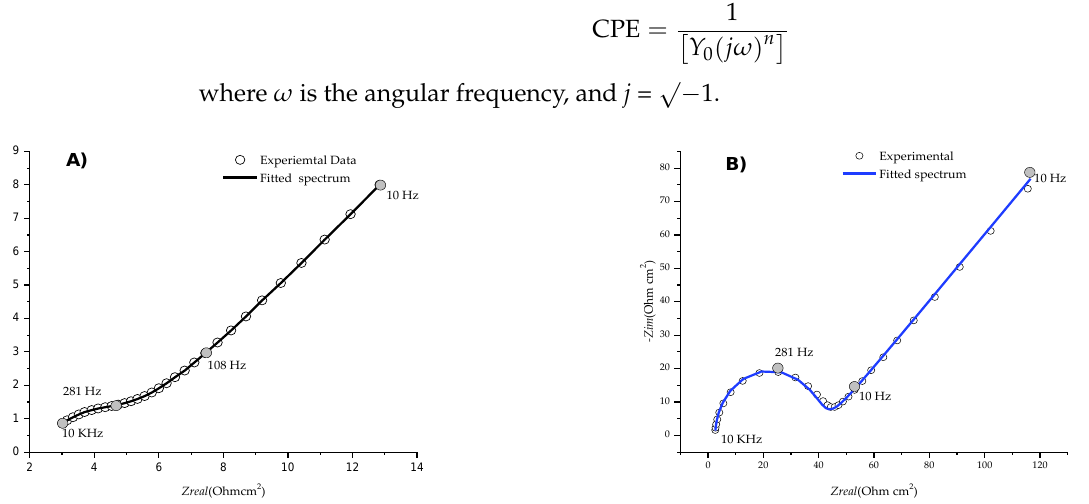
Figure 3. Impedance spectra of 2.5 mM Fe(CN) 63 − /Fe(CN) 64 − in the presence of 0.1 M phosphate buffer, pH 7.2, obtained with ( A ) bare Au electrode and ( B ) after modification with [B 12 H 11 SH] 2 − .